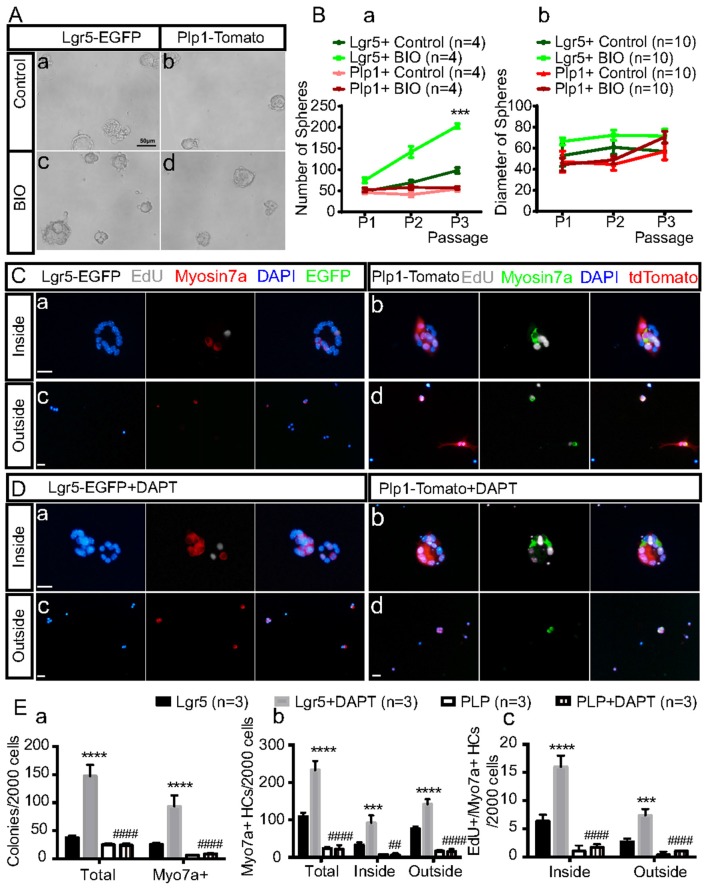
Sorted Lgr5+ SCs and Plp1+ SCs during sphere formation and HC differentiation in response to Wnt and Notch signaling in vitro. (A) Activation of the Wnt signaling pathway with BIO during neurosphere formation from the first generation in both subsets of purified SCs in vitro
(Ac,d). The control group was cultured only with media (Aa,b). (B) Quantification of the sphere number (Ba) and sphere diameter (Bb) formed from both subsets of SCs in the BIO and control group over the first three generations ***p < 0.001 (Lgr5+Control vs. Lgr5+BIO). (C,D) HC differentiation assay with purified Lgr5+ (Ca,c,Da,c) or Plp1+ (Cb,d,Db,d) SCs in the presence of Notch inhibition by DAPT. The inside of the colonies represents the mitotically regenerated HCs (Ca,b,Da,b), and the outside of the colonies represents the directly differentiated HCs (Cc,d,Dc,d). (E) Quantification of total colonies, Myosin7a+ colonies and Myosin7a+ cells and Myosin7a+/EdU+ cells both inside and outside the colonies. Data are shown as the mean ± SD. ***p < 0.001, ****p < 0.0001 (Lgr5 vs. Lgr5+DAPT).##p < 0.01, ####p < 0.0001 (Lgr5+DAPT vs. PLP+DAPT). In (Ba), n = 4. In (Bb), n = 10. In (E), n = 3. Scale bars are 50 μm in (A) and 20 μm in (C,D).